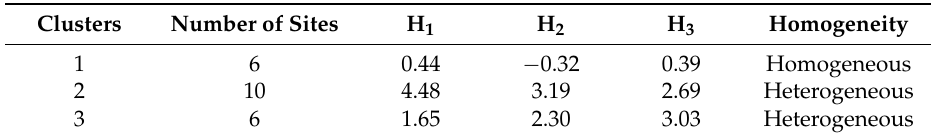
Figure 3. Formation of three groups through the cluster analysis. Table 4. Characteristics of the initial clusters.